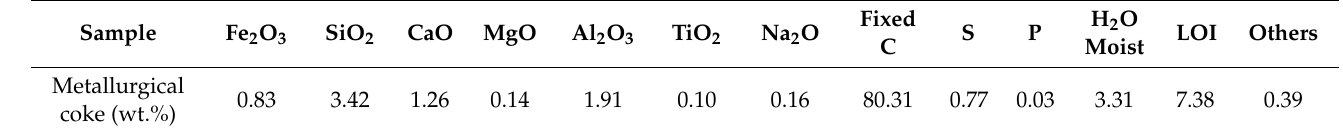
Table 3. Metallurgical coke chemical analysis.